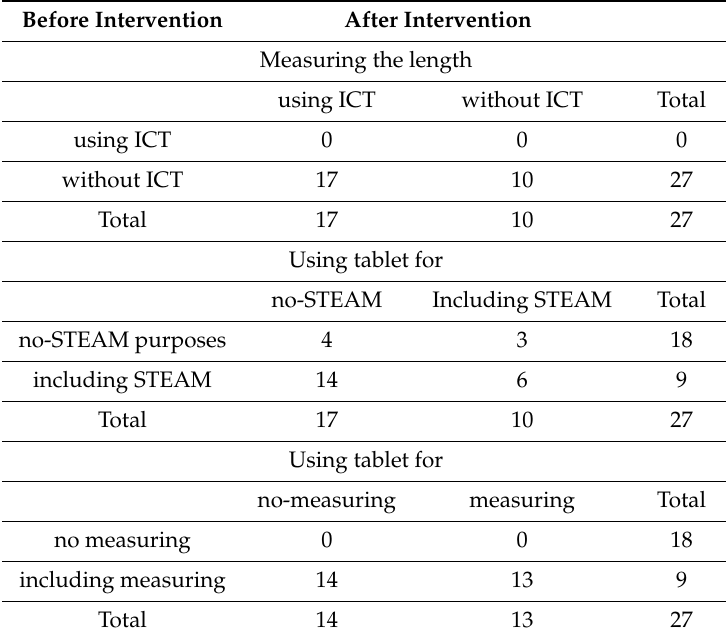
Table 1. Students’ responses to the chosen items in pre- and post-questionnaire. Before Intervention After Intervention Measuring the length using ICT without ICT Total using ICT 0 0 0 without ICT 17 10 27 Total 17 10 27 Using tablet for no-STEAM Including STEAM Total no-STEAM purposes 4 3 18 including STEAM 14 6 9 Total 17 10 27 Using tablet for no-measuring measuring Total no measuring 0 0 18 including measuring 14 13 9 Total 14 13